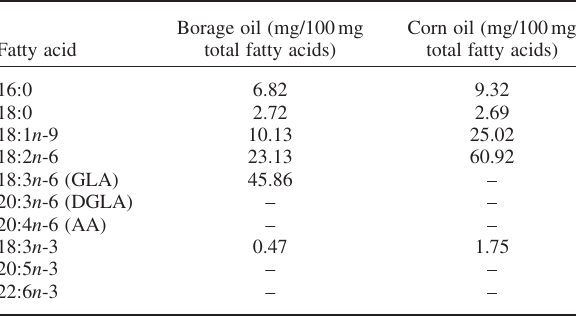
The data show serum fatty acid profiles at 3 month TABLE I Fatty acid composition of dietary capsules intervals over the 12 months of the study. There was a Borage oil (mg/100mg Corn oil (mg/100mg statistically significant increase in GLA and DGLA in Fatty acid total fatty acids) total fatty acids)